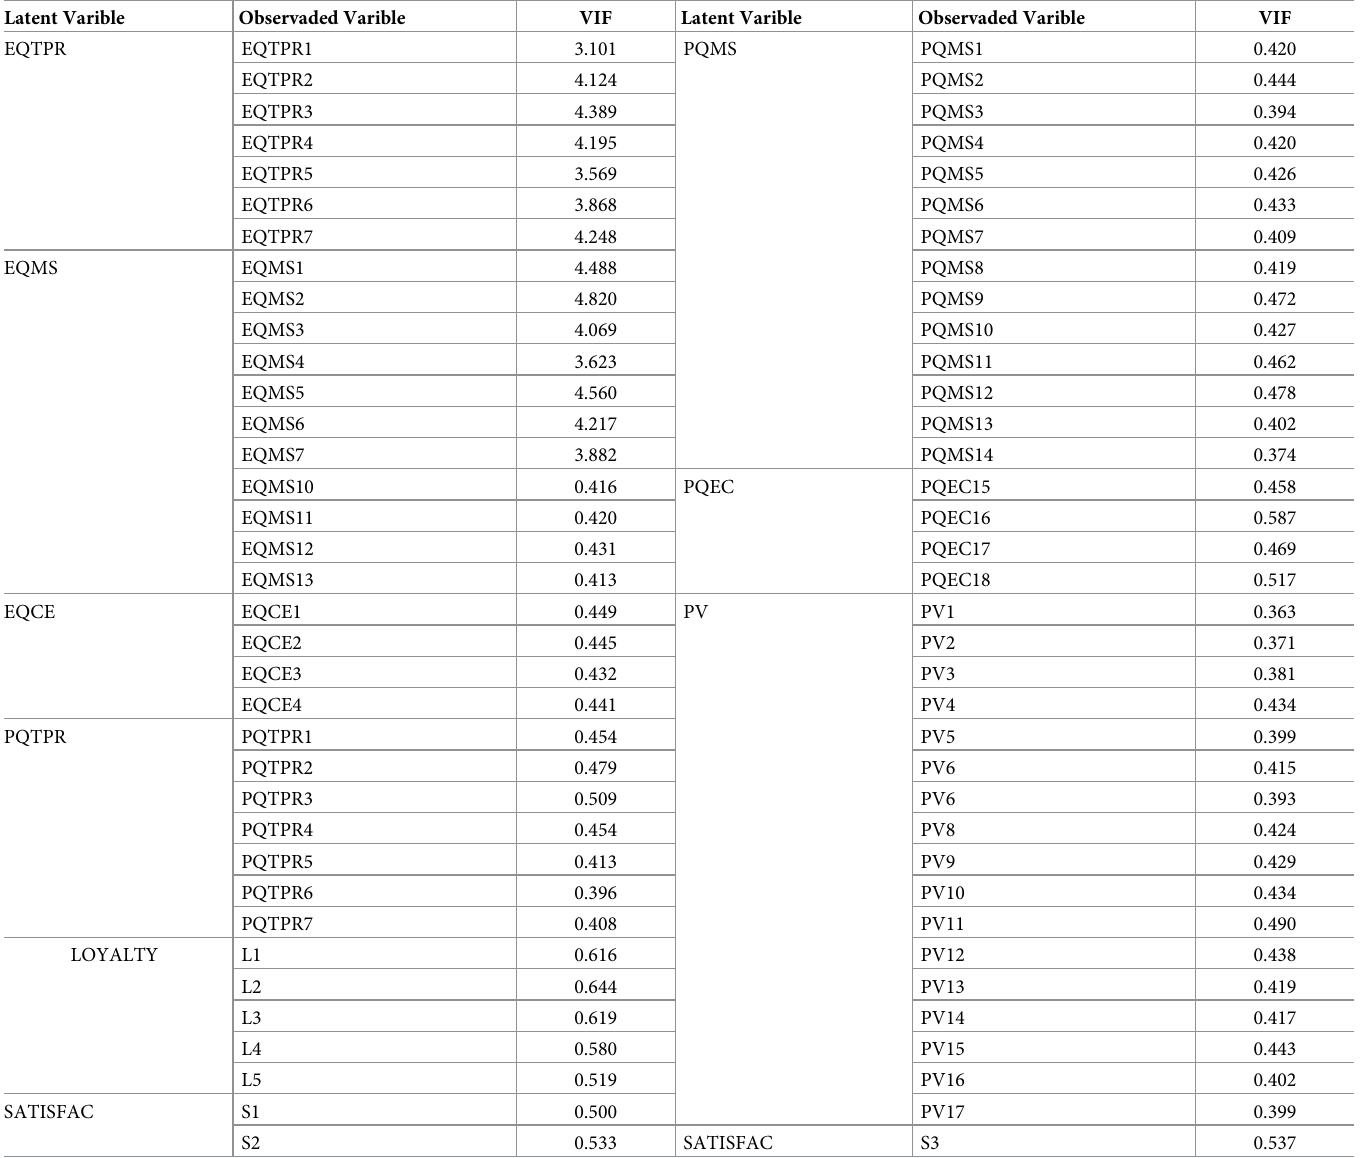
Table 5. Individual VIF of the